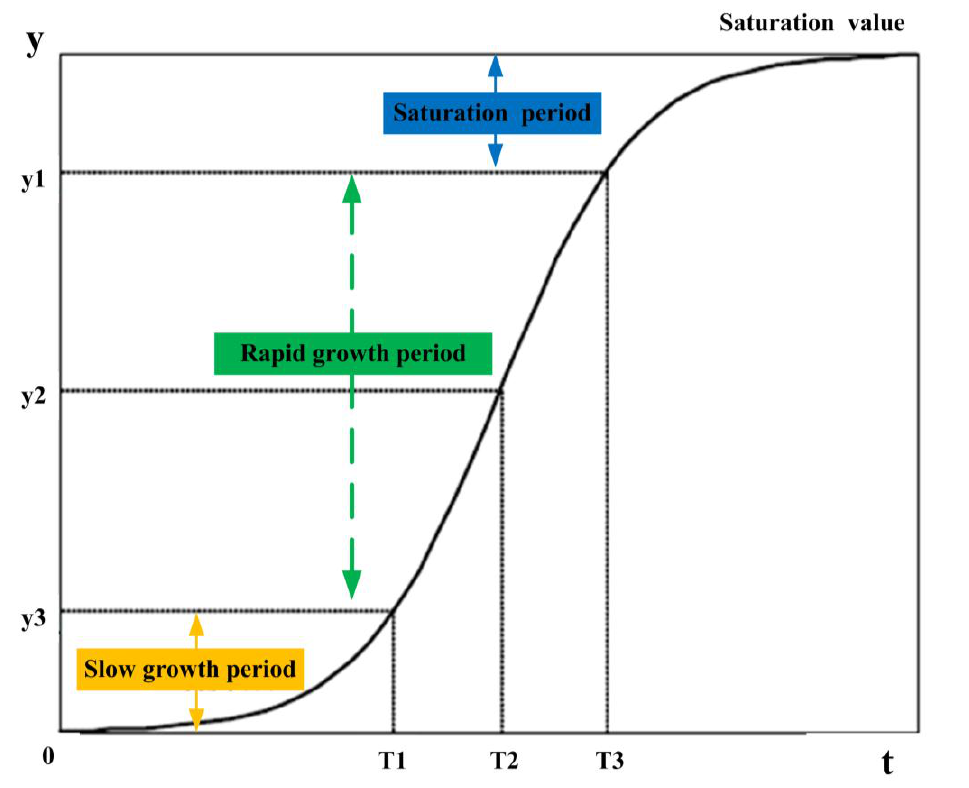
Figure 1. Logistic curve